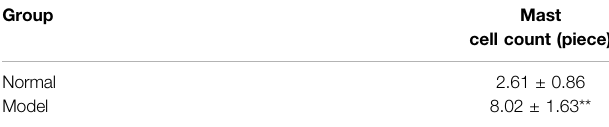
TABLE 1 | The number of the mast cells in proximal colon (mean ± SD, n = 5). Group